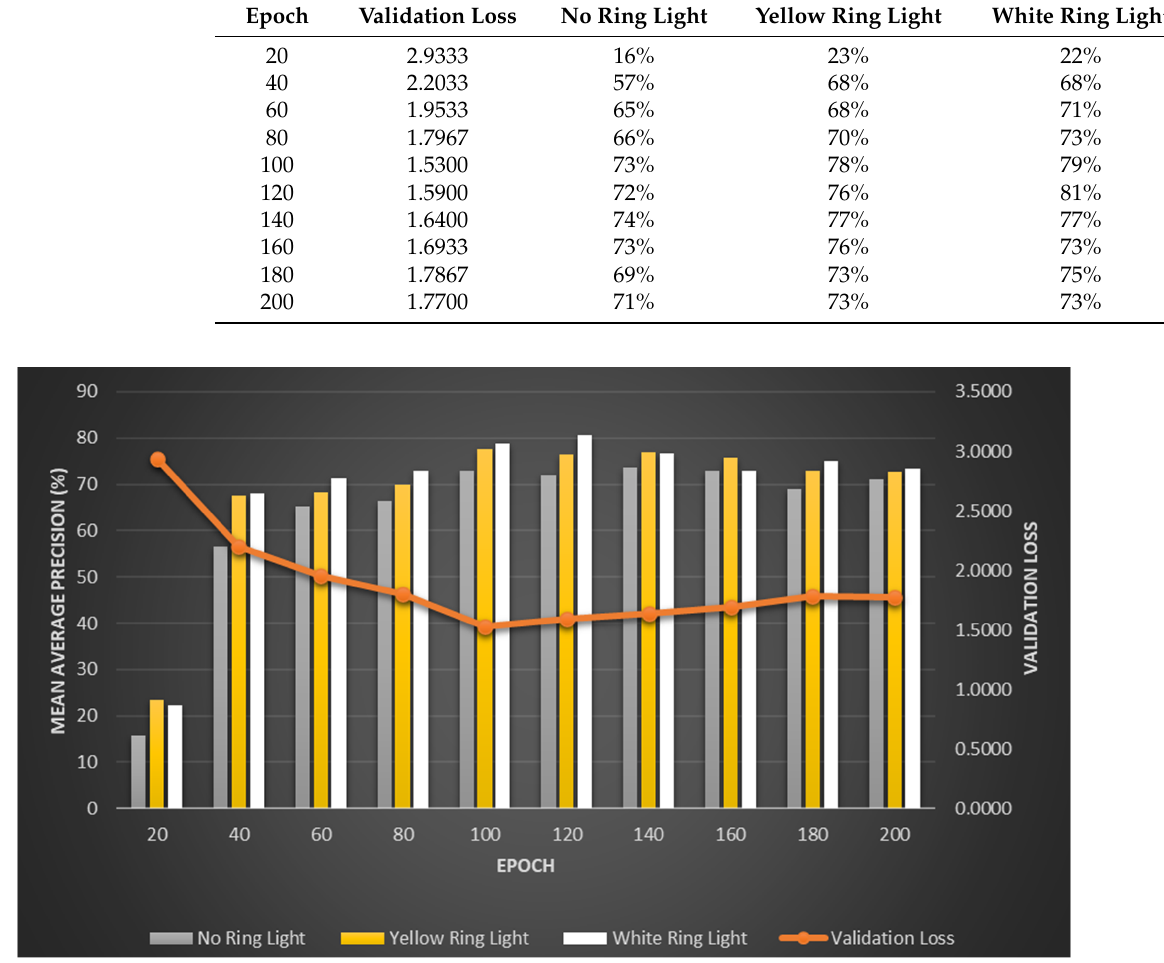
Figure 7. Bar chart comparison of mAP, including validation loss.